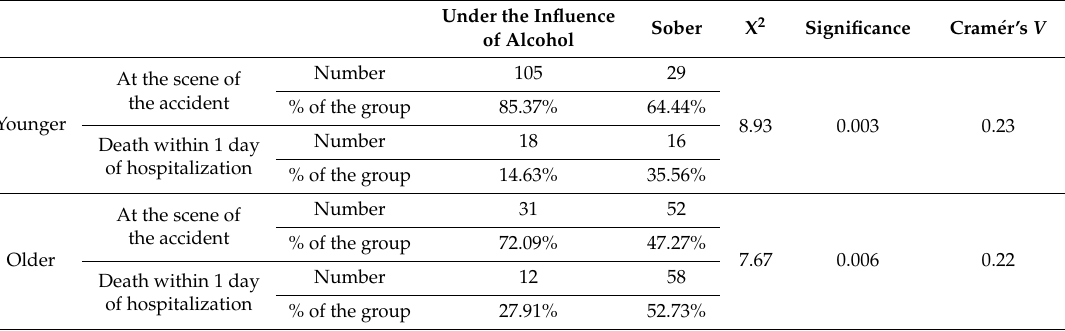
Table 7. Number of victims by group, location of death, and age